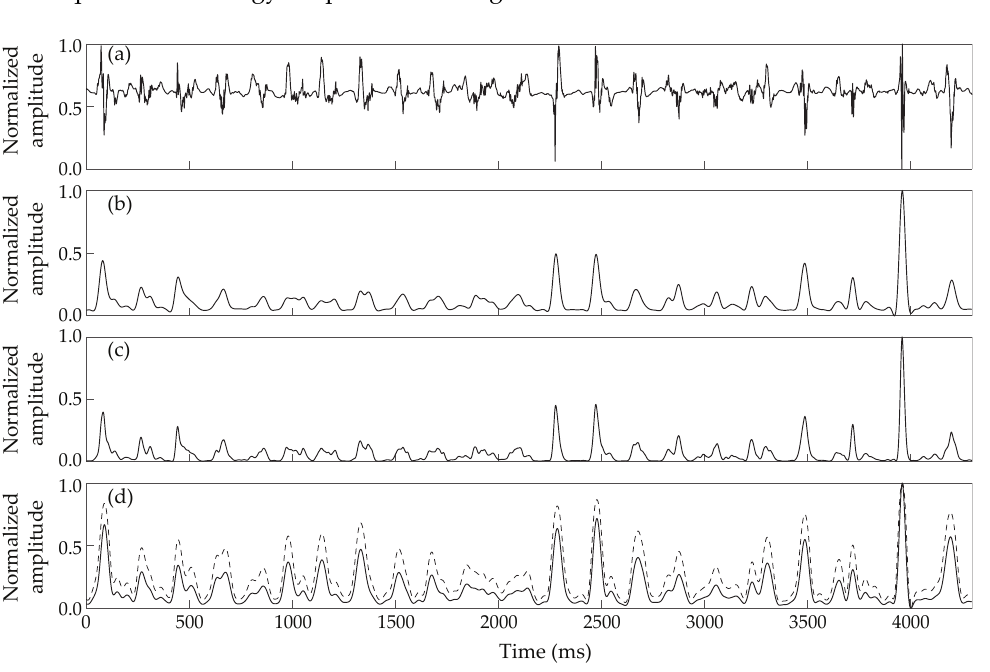
Figure 1. Comparative analysis of the preprocessing stage of each of the compared LAW detection methods applied on the same EGM: ( a ) Denoised EGM to be processed; ( b ) Result of AAT prepro- cessing; ( c ) Result of ACLI preprocessing; ( d ) Result of HT preprocessing. The dashed line in ( d ) corresponds to the application of the hyperbolic